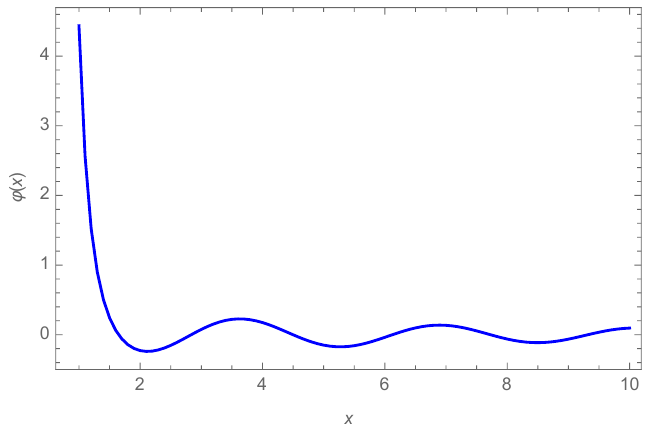
(cid:0) | (cid:1) ν | − Ω (also dimensionless).